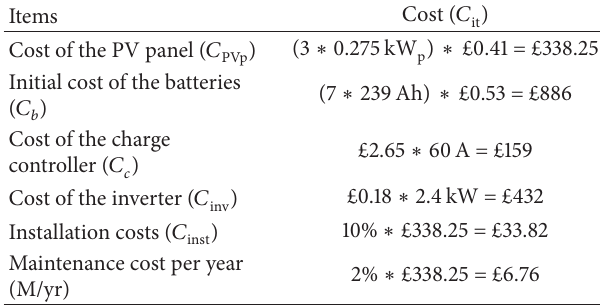
Table 5: Total cost of items [16, 17,